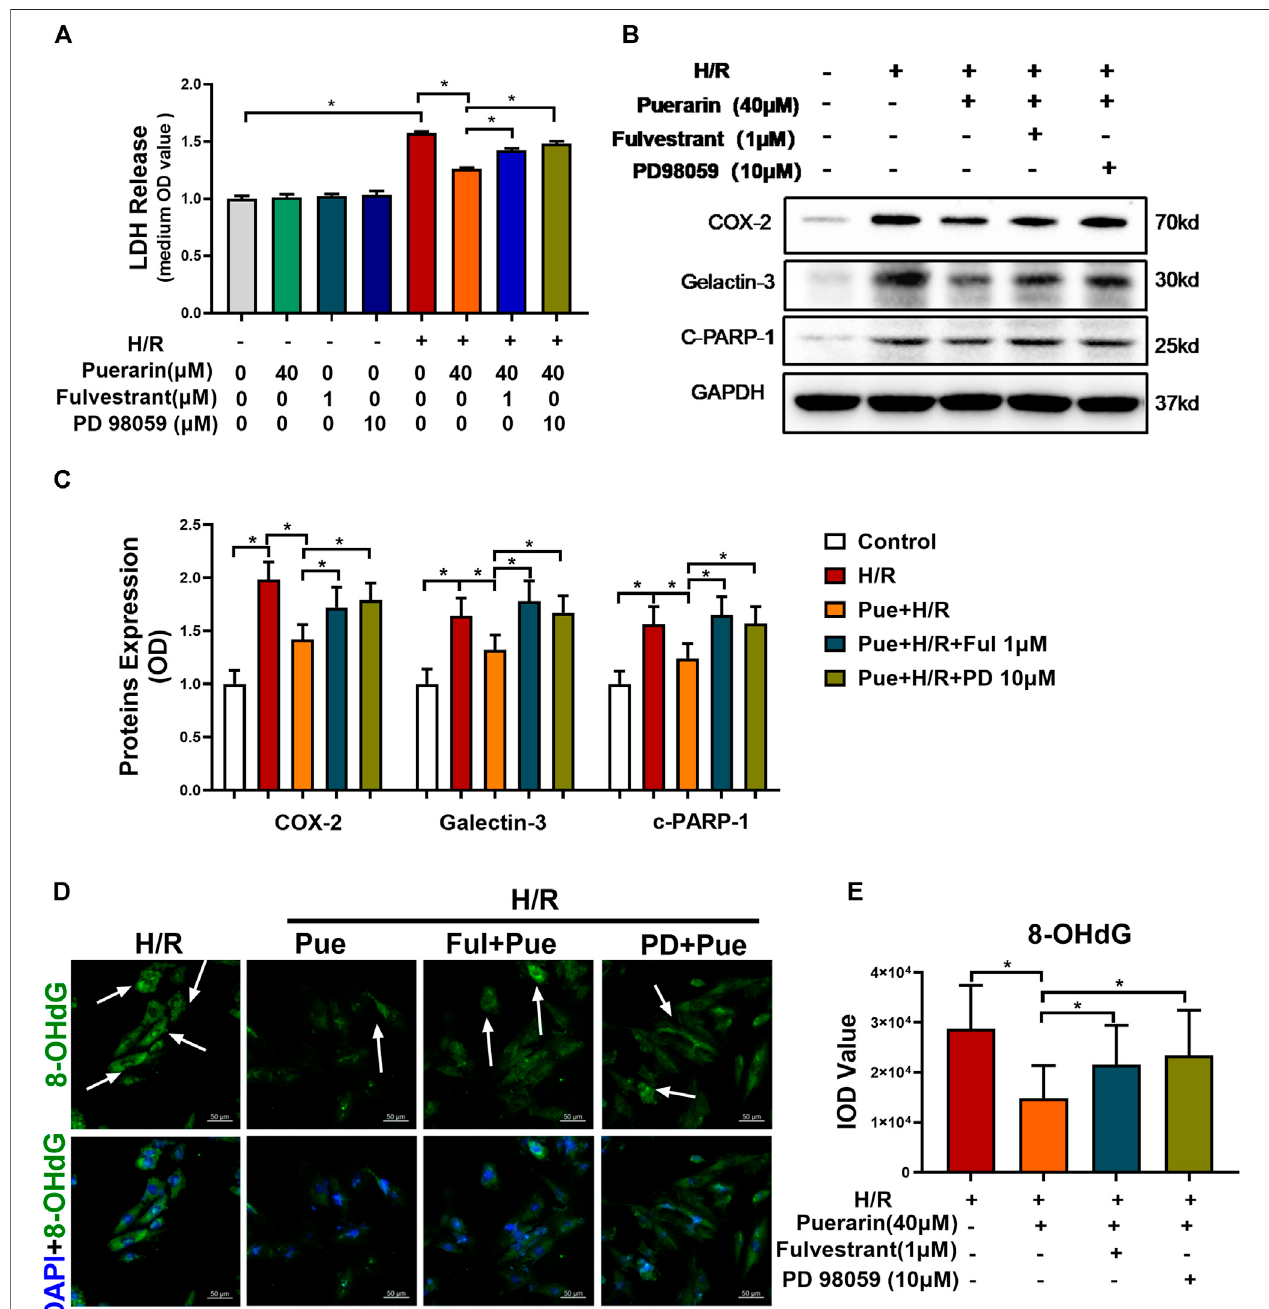
FIGURE7| PuerarinprotectedH9c2cellsagainsthypoxia/reoxygenation injuryviatheER/ERK signalingpathway. (A) DeterminationofLDHrelease.Followingthe treatment with puerarin-40 μ M alone or in combination with Fulvestrant-1 μ M or PD 98059-10 μ M for 1 h, the H9c2 cells were challenged by hypoxia for 3 h and reoxygenation for 24 h and assayed for LDH release by LDH cytotoxicity assay ( n (cid:2) 3). (B) Western blot analysis of COX2, galectin-3 and cleaved-PARP-1 expression. Following drug treatment, H9c2 cells were collected and analyzed by Western blotting with antibodies against COX2, galectin-3, cleaved-PARP-1. (C) Quanti fi cationofCOX2,galectin-3andcleaved-PARP-1expression.Theresultswereshownasmean ± SD( n (cid:2) 3).* p < 0.05. (D) Immunostainingofthecellular8-OHdG. Followingdrugtreatment,H9c2cellswereprobedwithprimaryanti-8-OHdGantibodyandvisualizedwithAlexaFluor488-conjugated secondaryantibody,whereasthe cell nuclei were stained with DAPI. Scale bar, 50 μ m. (E) Quanti fi cation of 8-OHdG expression. The results were presented as mean ± SD ( n (cid:2) 3). * p < 0.05.